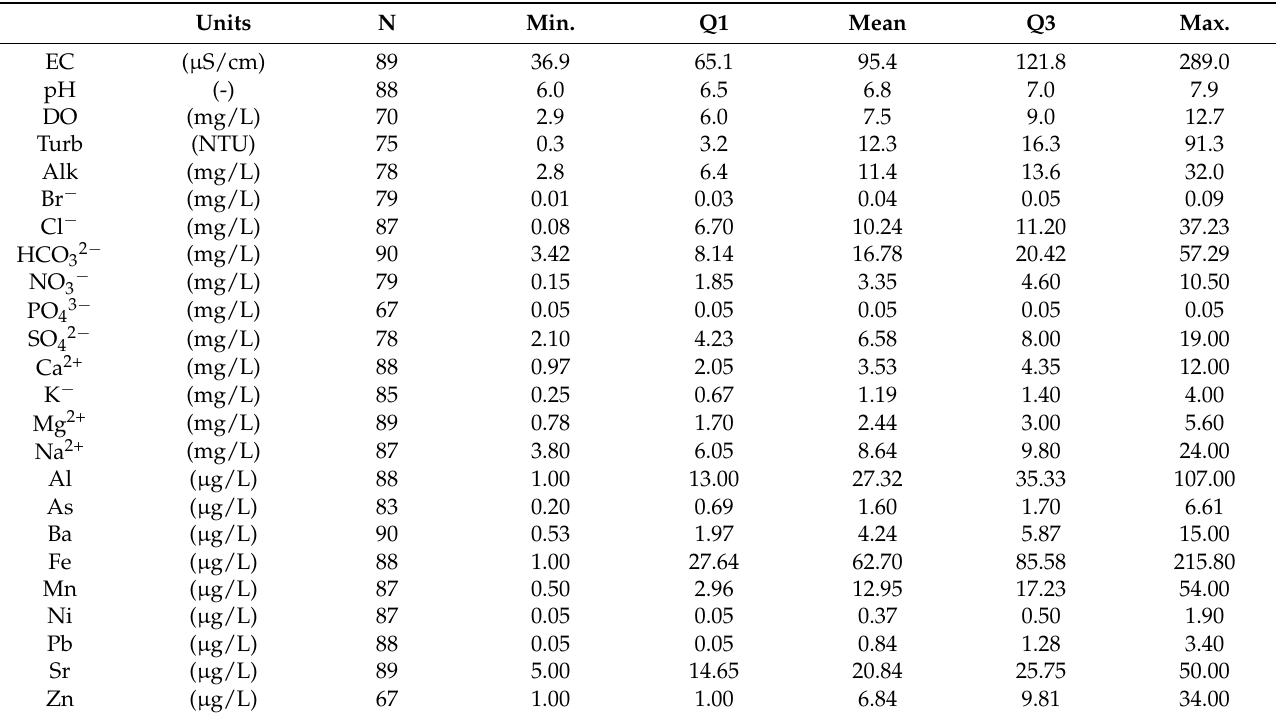
Table 3. Statistical representation of the studied parameters after removal of outlier values.